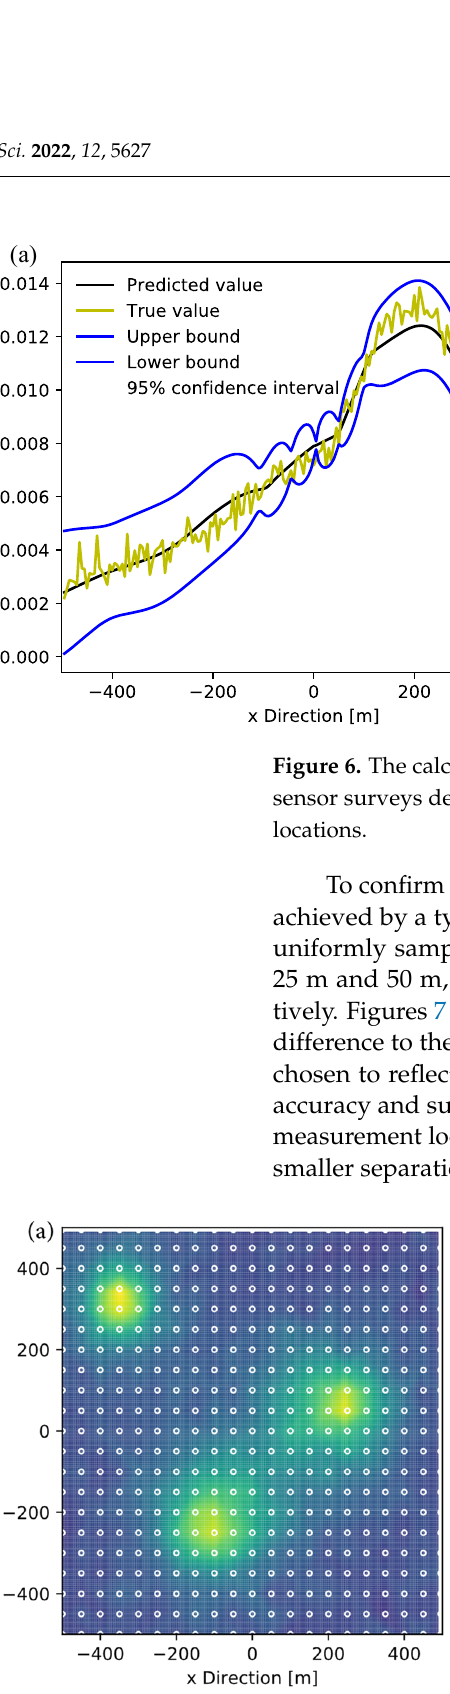
Figure 6. The calculated prediction uncertainty through y = 0 for ( a ) the five-sensor and ( b ) seven- sensor surveys demonstrating that prediction uncertainties decrease near the vicinity of observed locations.